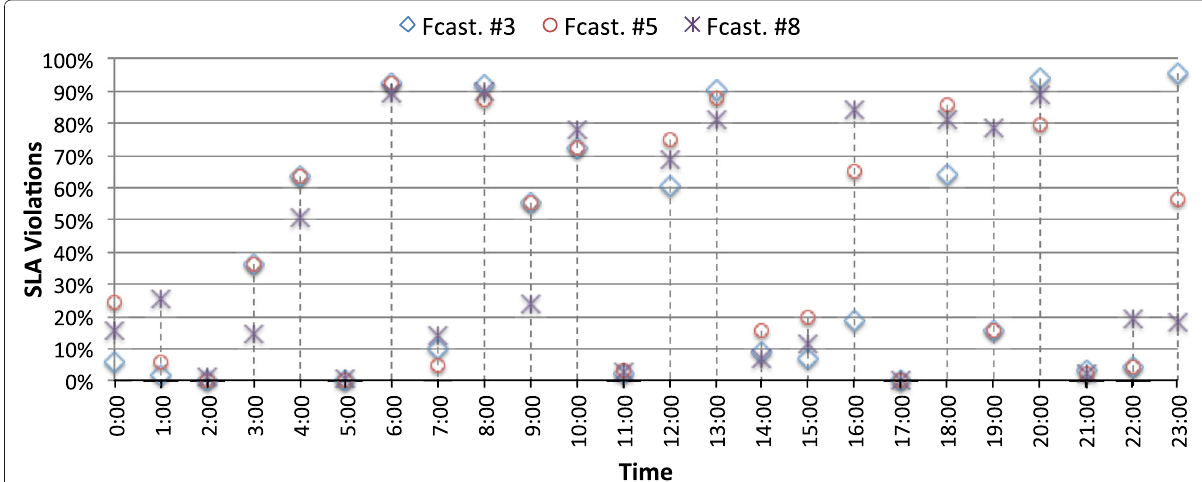
Fig. 8 Percentage of SLA violations for forecasting models #3, #5, and #8, based on the resource allocation of Table 4 This figure shows the percentage of SLA violations on each hourly period for forecasting models #3, #5, and #8 (in order to avoid a mesh of points in the graph, we have chosen these three cases in representation of the basic models, the polynomial SVM-based models, and the RBF SVM-based models,